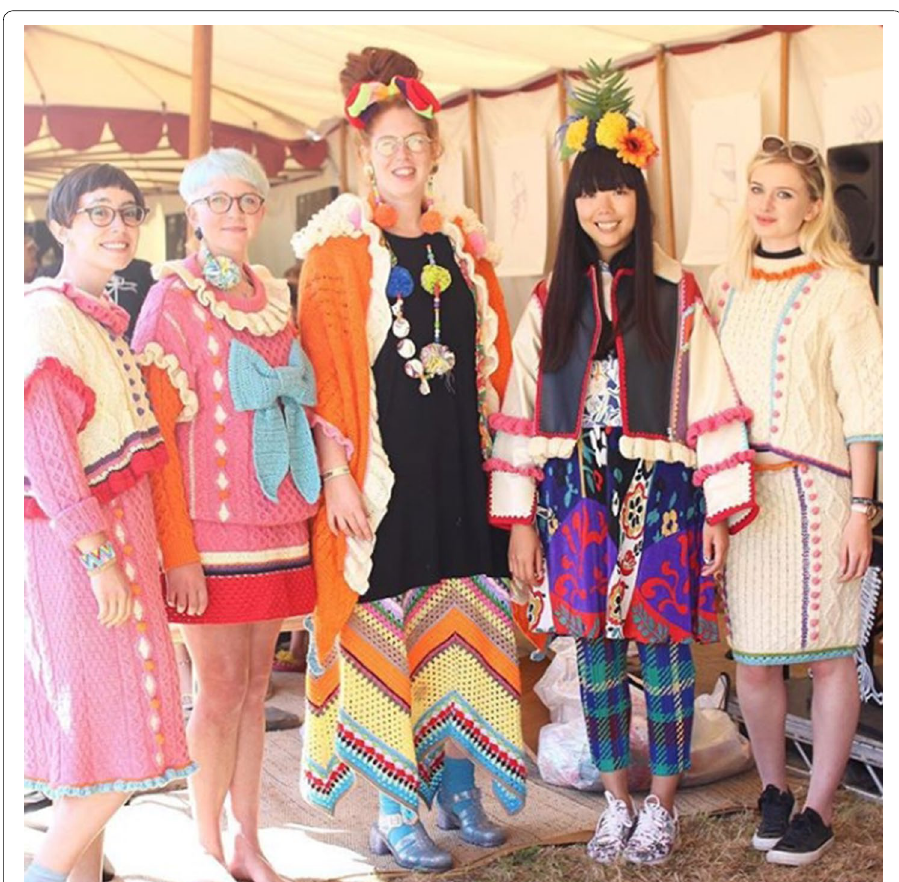
Fig. 16 Port Eliot festival. https ://www.insta gram.com/p/5z0BE JqavL /. Accessed 3 October